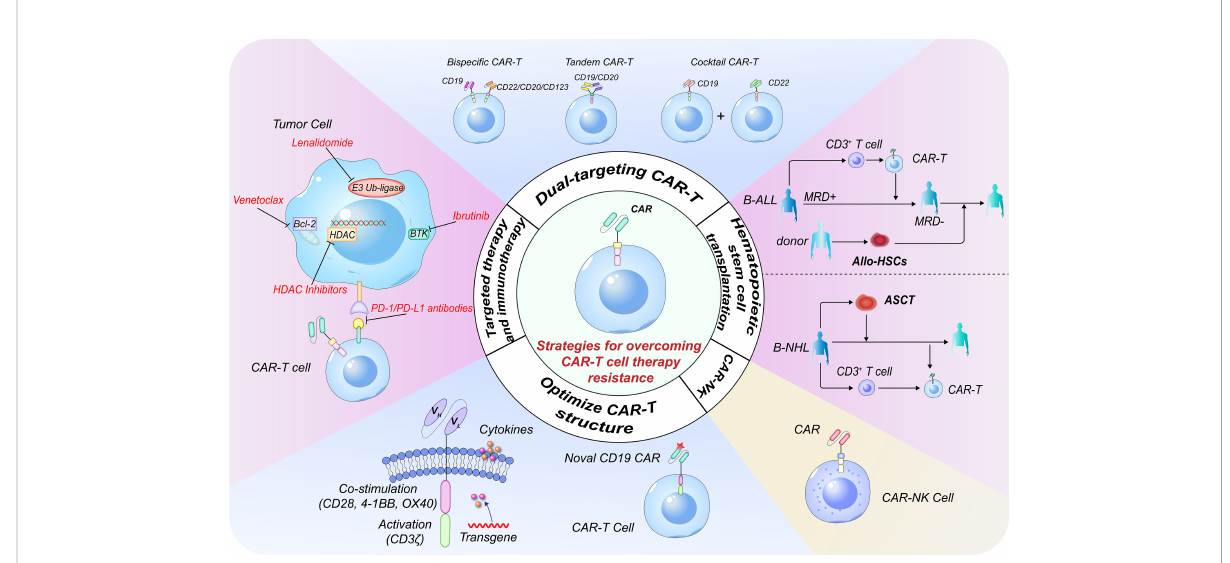
FIGURE 1 Strategies to overcome resistance in CD19 CAR-T cell therapy. Targeting multiple antigens is a pivotal strategy for overcoming CD19 - relapse. The three most common dual-targeting CAR-T cell therapeutic strategies include bispeci fi c CAR-T cells, tandem CAR-T cells, and ‘ cocktail ’ CAR-T cell therapy. Constructing novel CD19 CAR-T cells targeting different binding epitopes is an alternative for CD19 - relapse. Constructing next-generation CAR-T cells with different co-stimulatory receptor domains or cytokines can further enhance the CAR-T cell persistence. Combination therapies with traditional therapeutic systems or targeted therapies are very important. The combination of CAR-T cells with HDACi, BTKi, BCL-2i or PD-1/PD-L1 antibody can restore the expression of tumor antigens, enhance in vivo persistence and ef fi cacy of CAR-T cells and result in synergistic anti-tumor effects. CAR-T cell therapy can effectively eliminate MRD and is a powerful strategy to bridge allo-SCT in B-ALL. CAR-T cell therapy combined with ASCT has signi fi cant synergistic effects in B-NHL. CAR-NK cell is another promising approach for patients with dif fi culty or inaccessible to CAR-T therapy. CAR, chimeric antigen receptor; HDACi, histone deacetylase inhibitor; BTKi, Bruton ’ s tyrosine kinase inhibitor; BCL-2i, B-cell lymphoma-2 inhibitor; MRD, minimal residual disease; allo-SCT, allo-hematopoietic stem cell transplantation; B-ALL, B-cell acute lymphoblastic leukemia; ASCT, autologous stem cell transplantation; B-NHL, B-cell non-Hodgkin